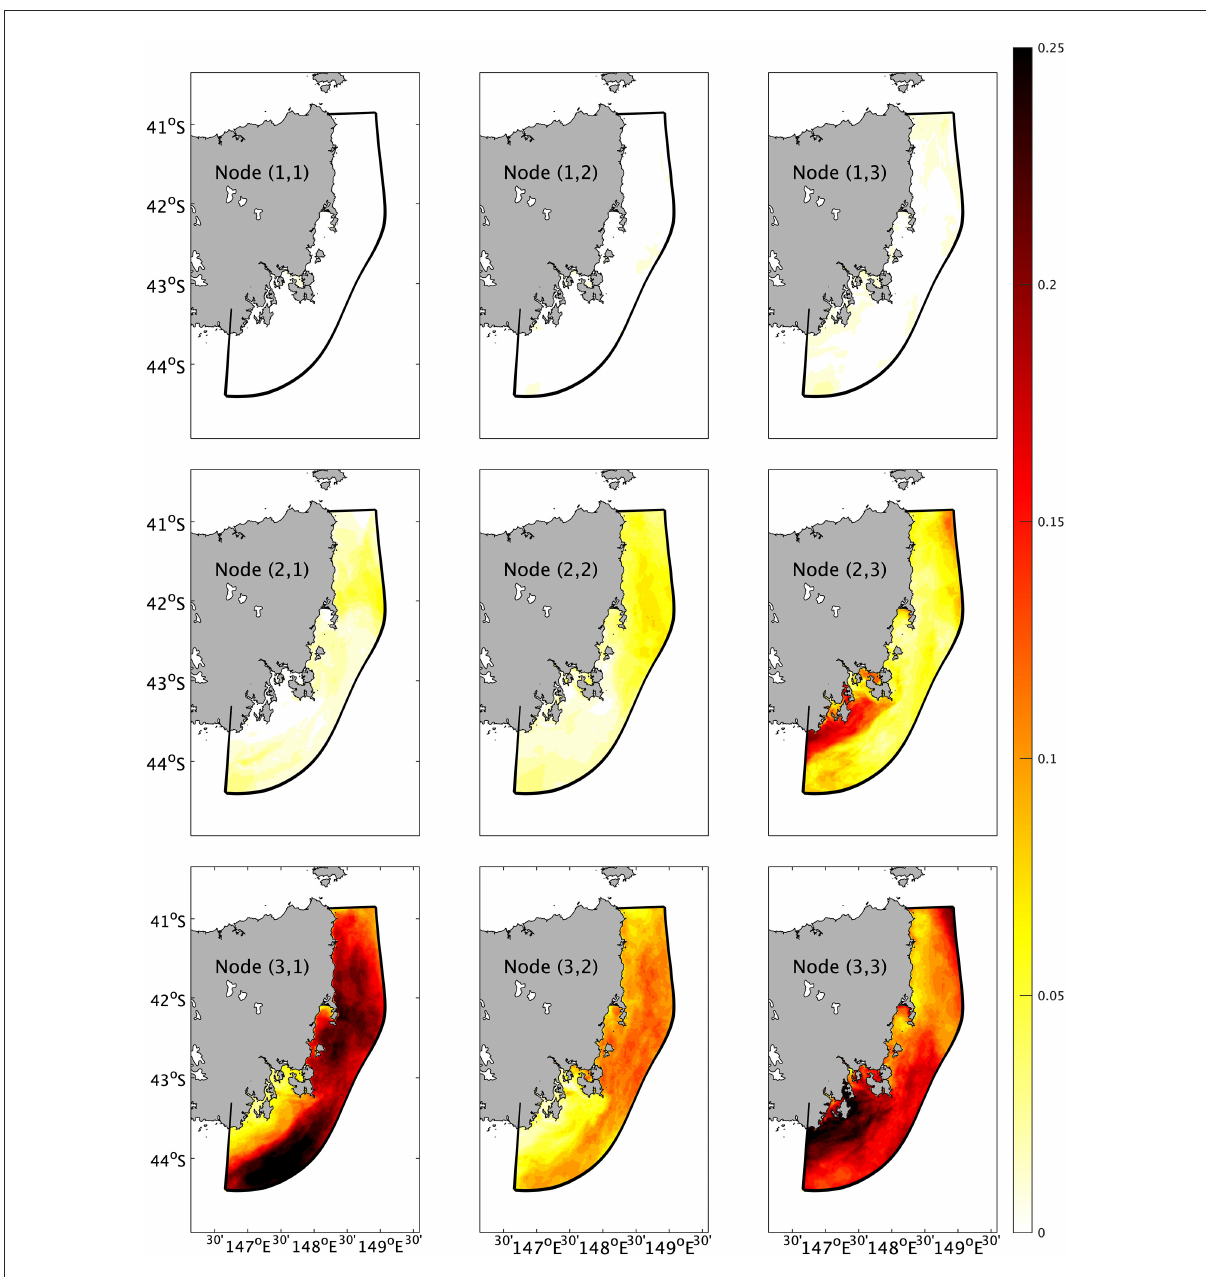
FIGURE5 The proportion of MHW days in each node. Colours indicate the proportion of MHW days across all eddies in this node.